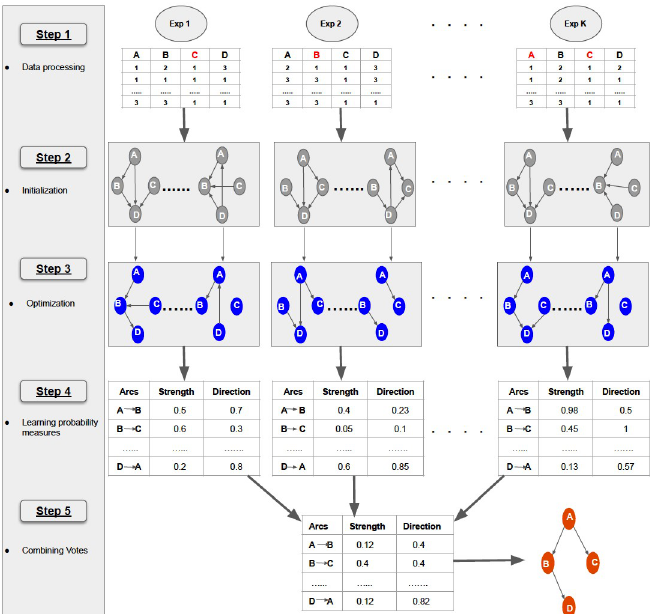
Fig 3. Workflow of “Learn and Vote”. Step 1 —Collecting data from k experiments (combination of observational and interventional studies). For interventional studies, the known targets (marked in Red) are incorporated as external perturbation during the search process. Step 2 —Creating 100 random DAGs using the observed nodes, as a starting point. Step 3 —Optimizing each of the 100 DAGs with data using Tabu search. Step 4 —Calculating probability (in terms of strength and direction) of occurrence for every possible arc from the 100 optimized DAGs and storing them in tables. Step 5 —Combining votes from all the tables by weighted averaging and constructing the final causal network, with arc strengths above a threshold (in this case